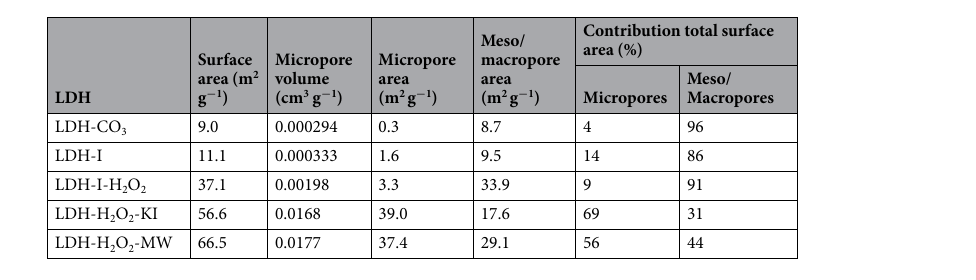
Table 1. Summary of surface properties and micropore volume of all